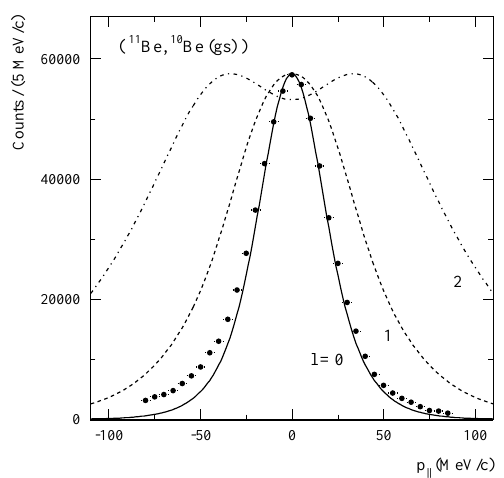
FIG. 2. p jj distribution of the 10 Be fragments in the rest frame Figure 3: Parallel-momentum distribution of the 10 Be core of the one-neutron halo of the projectile. Only the contribution leading to the ground nucleus 11 Be following its one-neutron removal reaction on Be at 60 MeV / nucleon. state of 10 Be is shown. The curves are calculations assuming a knockout reaction from s , p , and d states.